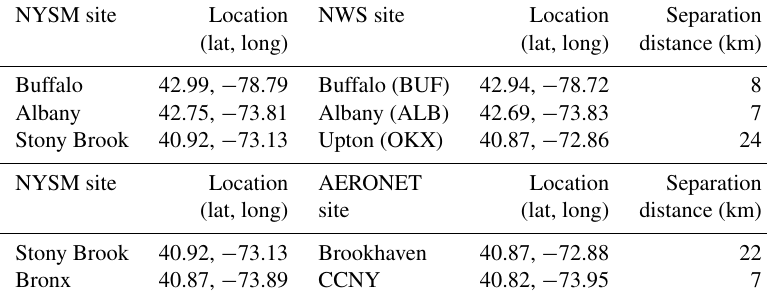
Table 2. NYSM, NWS, and AERONET site